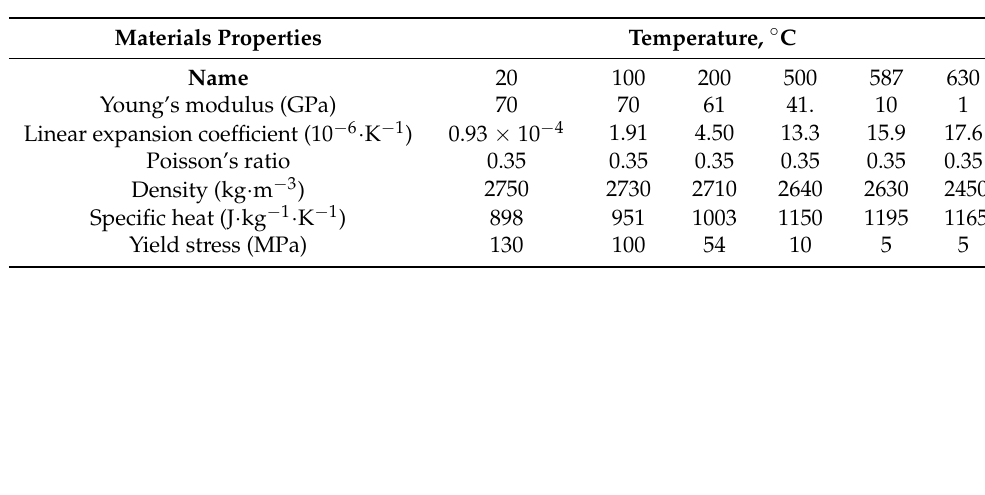
Table 3. Material properties of 5A06 aluminum